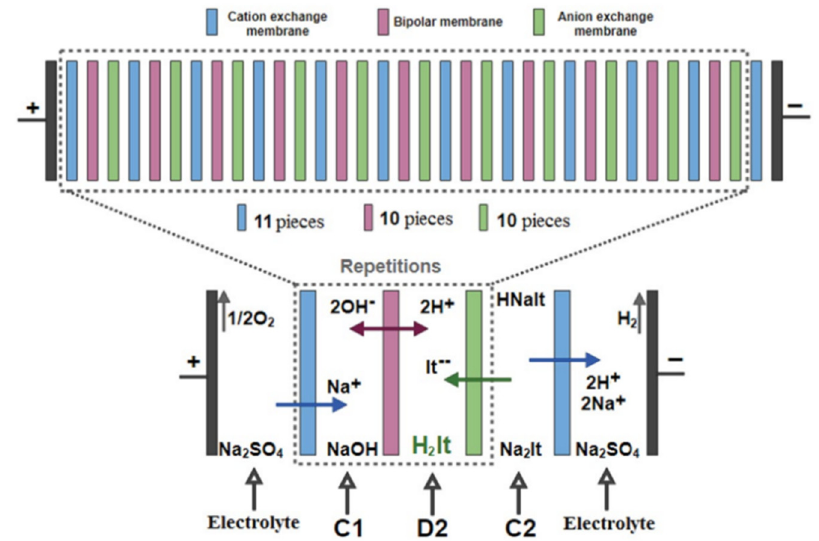
Figure 10. Scheme of the membrane module in the BMED and the predominant transport mechanisms during the separation, C 1 : NaOH compartment; D 2 : itaconic acid compartment; C 2 : itaconic acid sodium compartment [77].